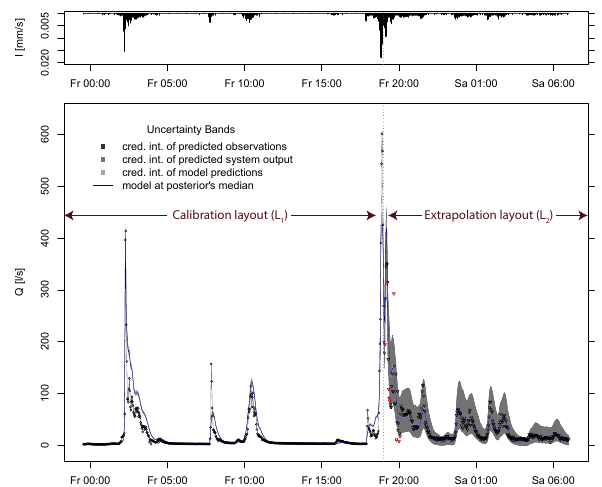
Fig. 4. Probabilistic runoff predictions for part of the calibration (left) and the validation period (right) with the constant bias model and log-sinh transformation. The input time series (hyetograph) is shown on the top. The observed hydrograph is represented by dots, with the triangular data points being used only for validation. The 95% credible intervals are interpreted as follows: parametric uncertainty due to y M (light gray), parametric plus input and structural uncertainty due to g − 1 (˜ y M + B M ) (intermediate), total uncertainty due to g − 1 (˜ y M + B M + E ) (dark gray). Validation data not included in this dark gray region are marked in red. The prediction intervals for the system output and the observations are almost indistinguishable and therefore only the intermediate gray band is visible at this scale.